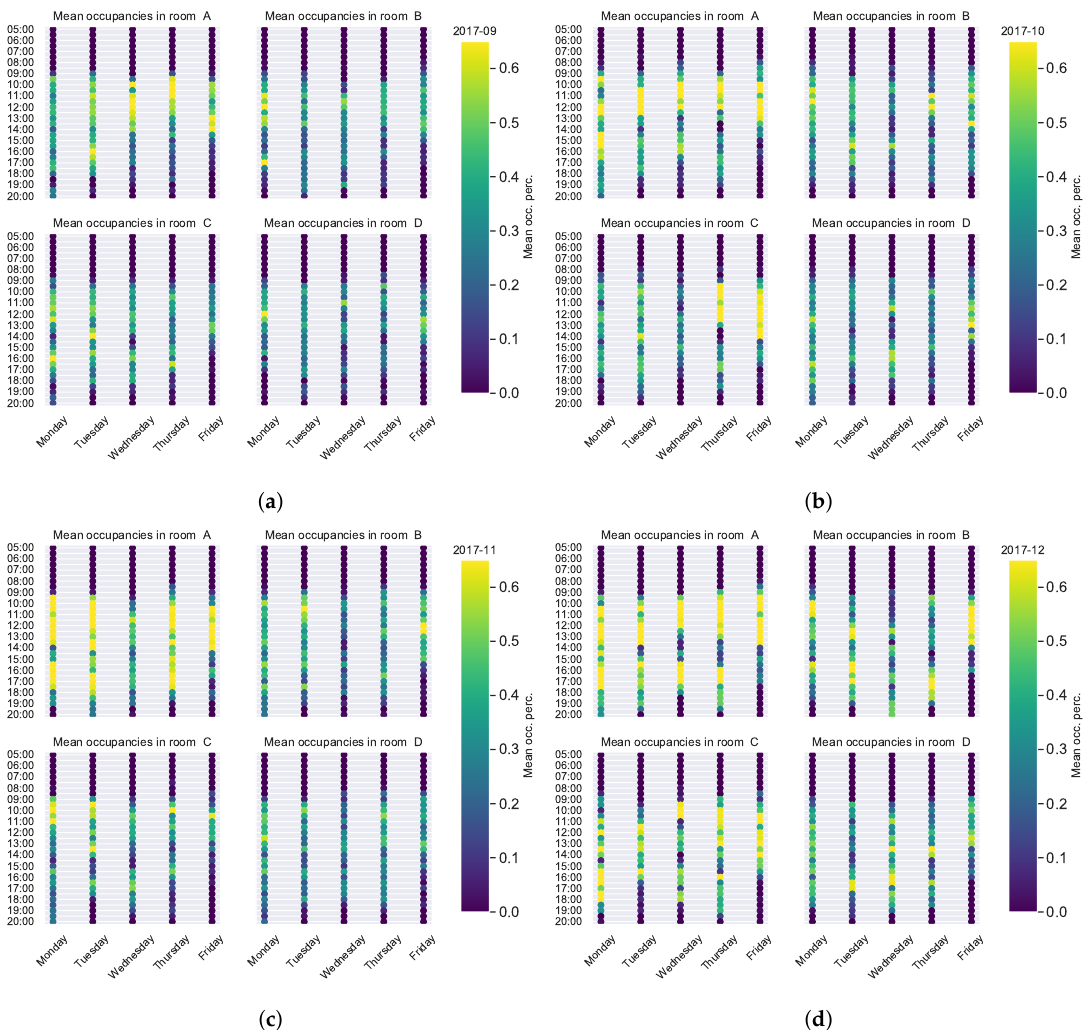
Figure 4. Calculated usage patterns for different months in each of the monitored meeting-rooms: ( a – d ) contain the usage patterns for September, October, November and December (2017) respectively. When computing the dissimilarities of the patterns between different months of the same room, Euclidean distance (see Equation (1)) between them take values of the order of 1–5 when the maximum difference could theoretically be 240 (as there are 240 entries in each month pattern: 1 value per 30 min, that is 48 values a day, or 240 values a work-week (Monday to Friday)). A summary of the Euclidean distances between the different month patterns per monitored room can be seen in Figure 5. Those Euclidean distances tell that the monthly usage patterns are similar between them and in consequence that the room usage is quite regular, and therefore, it should be possible to predict